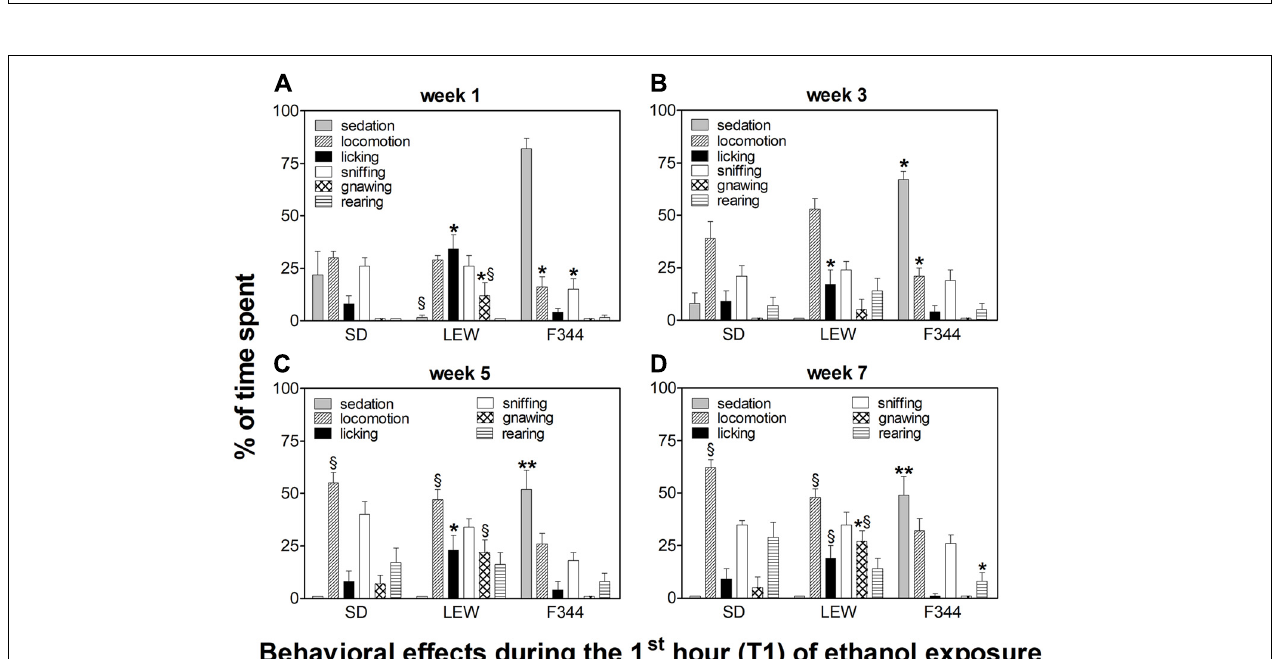
FIGURE 7 | Behavioral effects in adolescent onset rats during the first hour of the drinking session. Data are expressed as means ± SEM. (A) first week: data are referred to the first and third session of exposure; (B) third week: data are from the 9th session; (C) fifth week: data are from the 13th session; and (D) seventh week: data are from the 19th session. * p < 0.05 Lewis (LEW) vs. Sprague-Dawley (SD) and Fischer 344 (F344) strain, ** p < 0.001 F344 vs. LEW and SD, § p < 0.05 SD and LEW vs. F344 strain by one-way ANOVA followed by Tukey’s post hoc test.